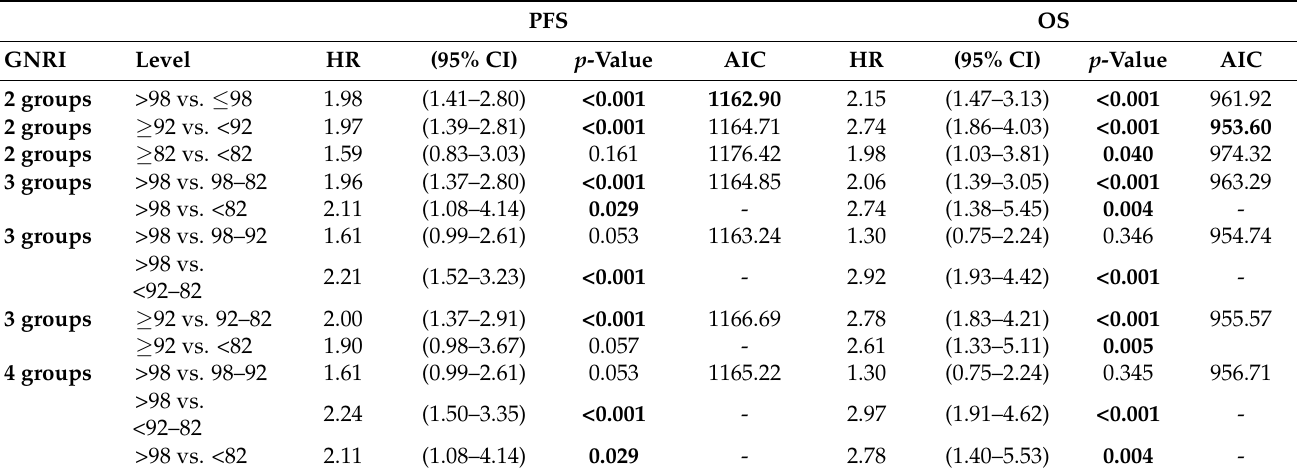
Table 2. AIC analysis of univariable Cox regression for PFS and OS of seven GNRI cut-off variants.